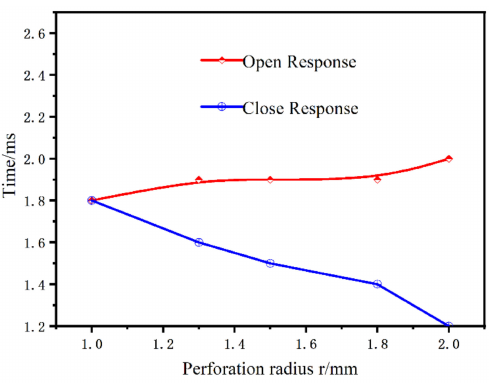
Figure 16. The relationship between the bore size and the dynamic response of the solenoid